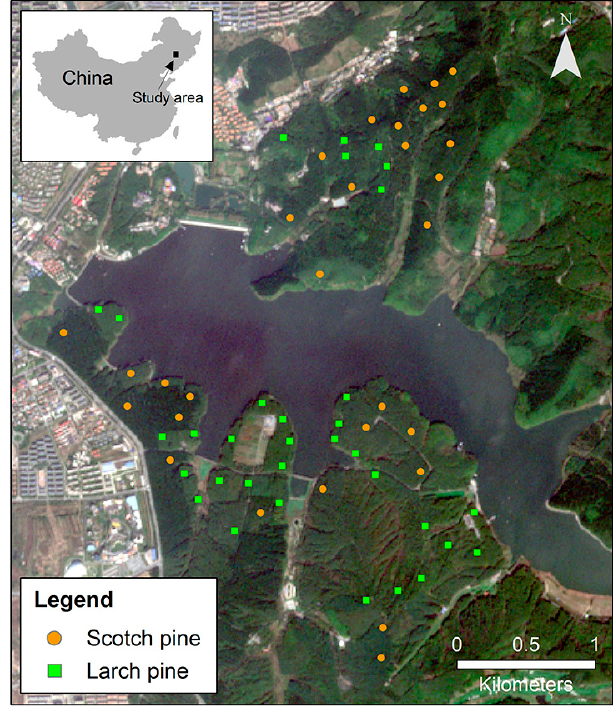
Figure 1. Location of the study area in China, and the distribution of sample plots on a natural color composite of Sentinel-2A image acquired in October 2016.